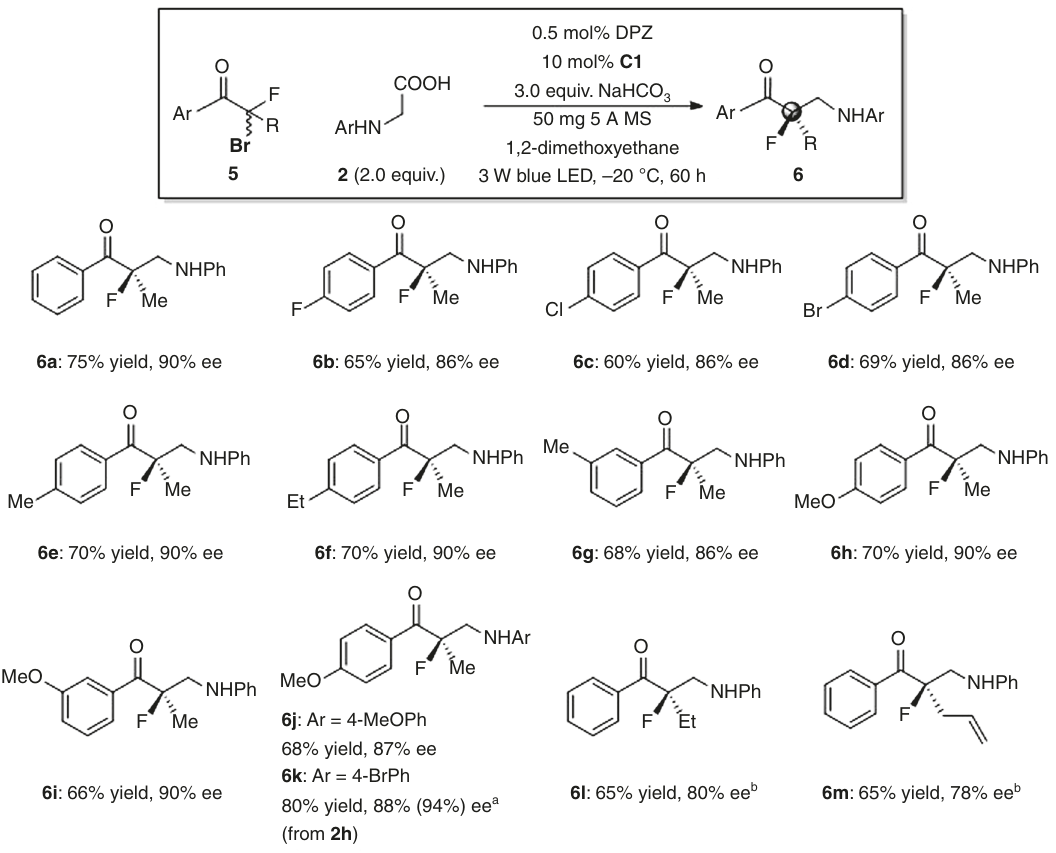
Fig. 3 Substrate scope of tertiary α -bromo- α - fl uoroketones with N -aryl glycines. Reactions were performed with 5 (0.1 mmol), 2 (0.2 mmol), DPZ (0.5 × 10 − 3 mmol), C1 (0.01 mmol), NaHCO 3 (0.3 mmol), and 5 Å MS (50 mg) in 1,2-dimethoxyethane (1.5 mL) at − 20 °C. Yields were determined from the isolated material after chromatographic puri fi cation. Enantiomeric excesses were determined by HPLC analysis on a chiral stationary phase. a The ee value in parenthesis was obtained after recrystallization. b Catalyst C3 (20 mol%) was used instead of C1 and T = − 45